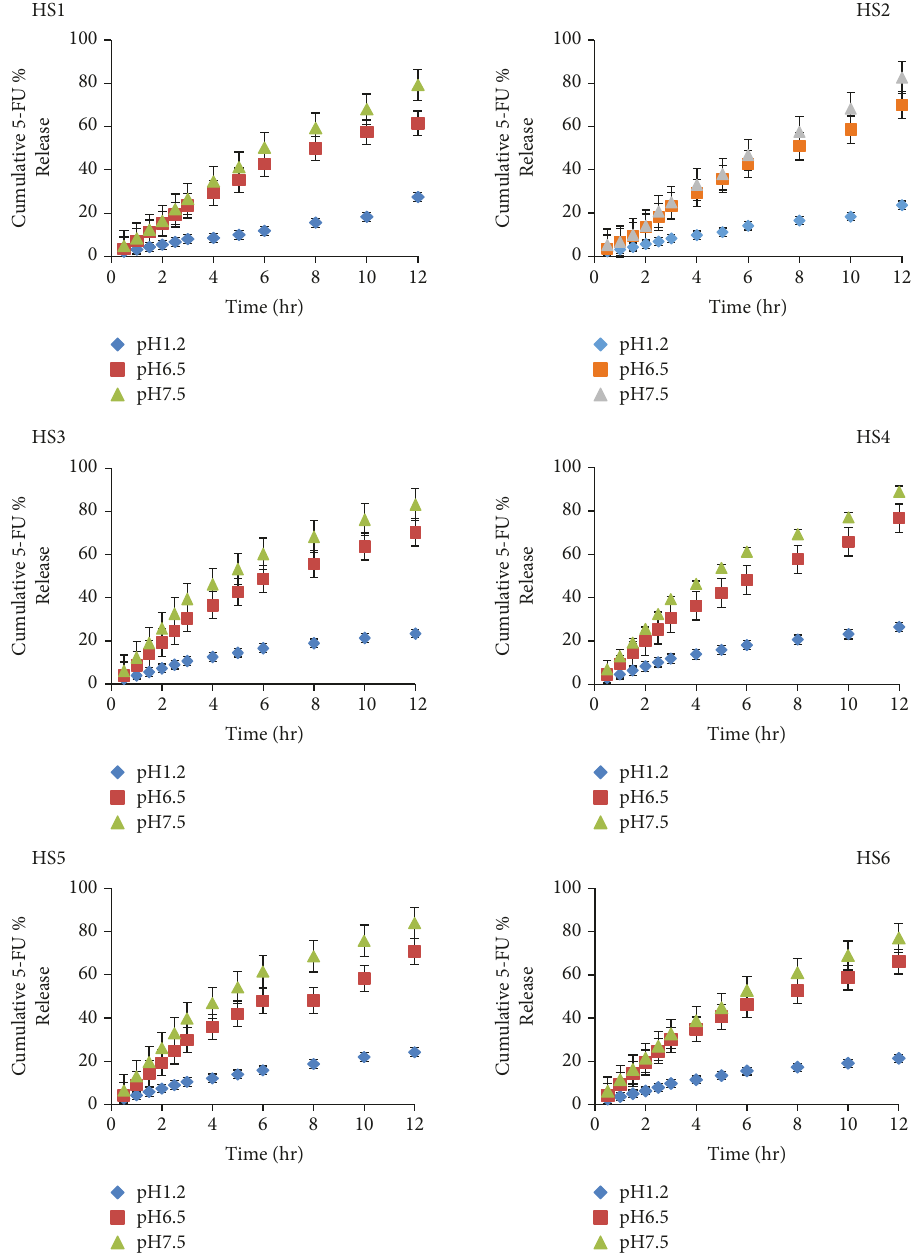
Figure 7: Cumulative 5-FU % release from Poly (CMCS- g -AA) hydrogels with time at various pH values and 37 ° C in 0.05M USP phosphate bu ff er